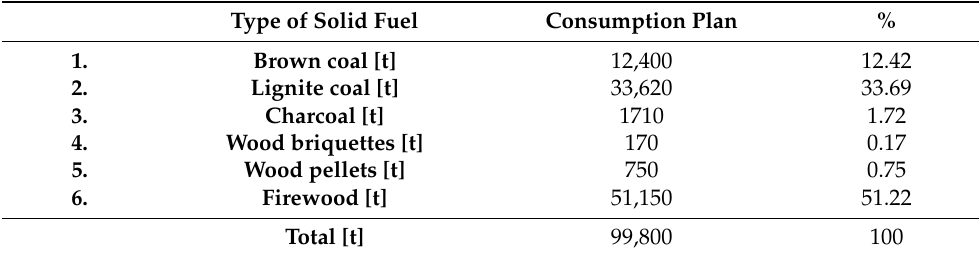
Table 4. Overview of solid fuel needs in Sarajevo Canton for 2018 [21].